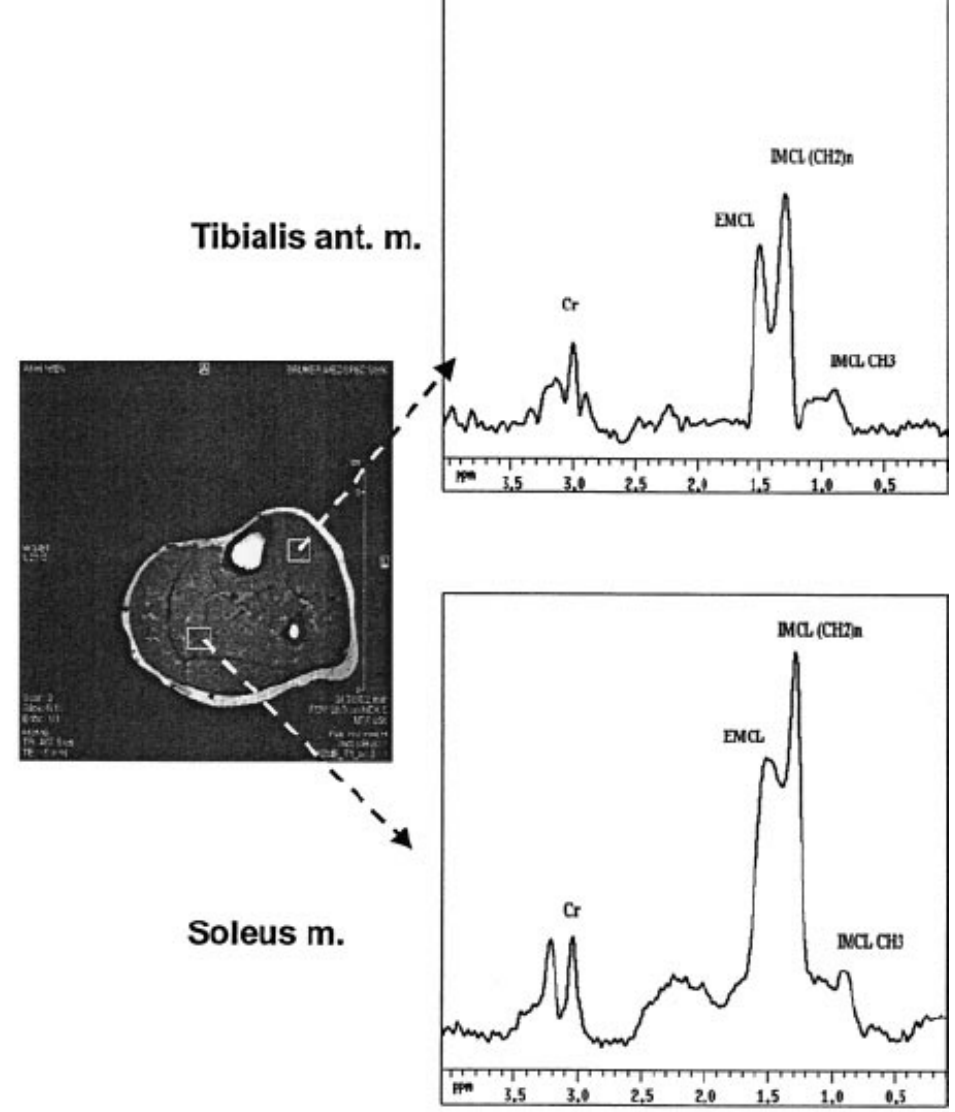
Figure 2. The cross-sectional image of human calf muscle via magnetic resonance imaging ( left side ). HNMR spectra attained from volumes of soleus and tibialis anterior muscles ( right side ) [33].